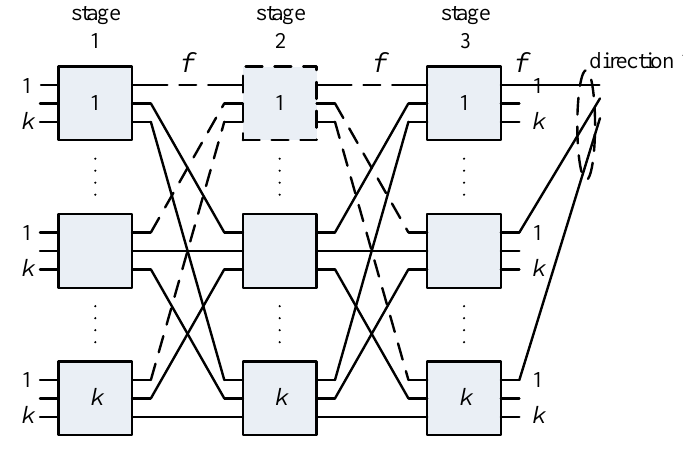
Figure 5. Three-stage Clos switching